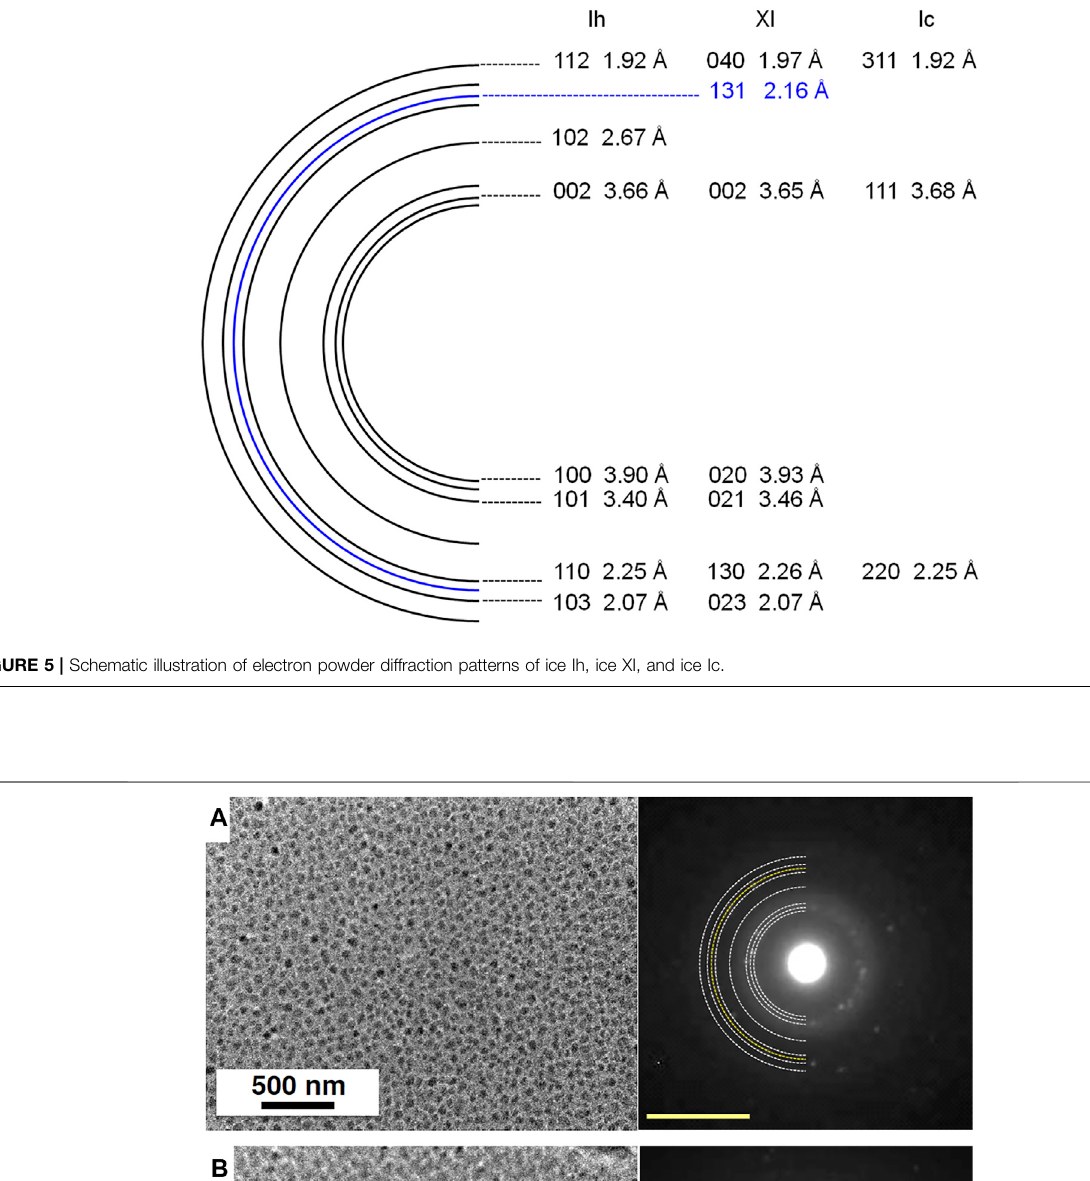
Frontiers in Chemistry |